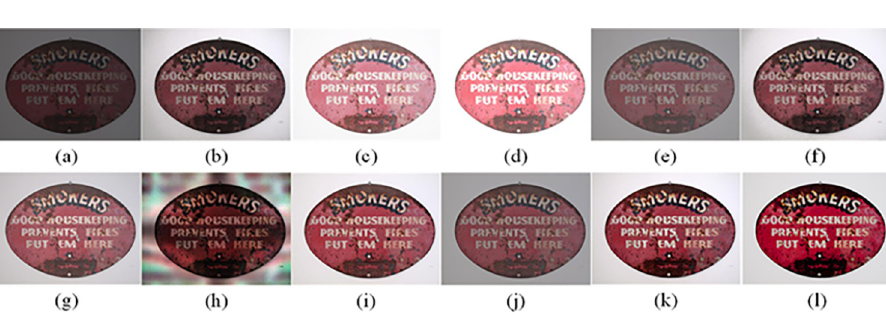
Fig 19. Comparisons of the ten algorithms in enhancing low-light image 9. (a) low-light image (b) AGCWD (c) Al- Ameen (d) BHE2PL (e) BIMEF (f) BPDHE (g) LIME (h) MSRCR (i) NPEA (j) SRIE (k) OURS (l) Normal light image.